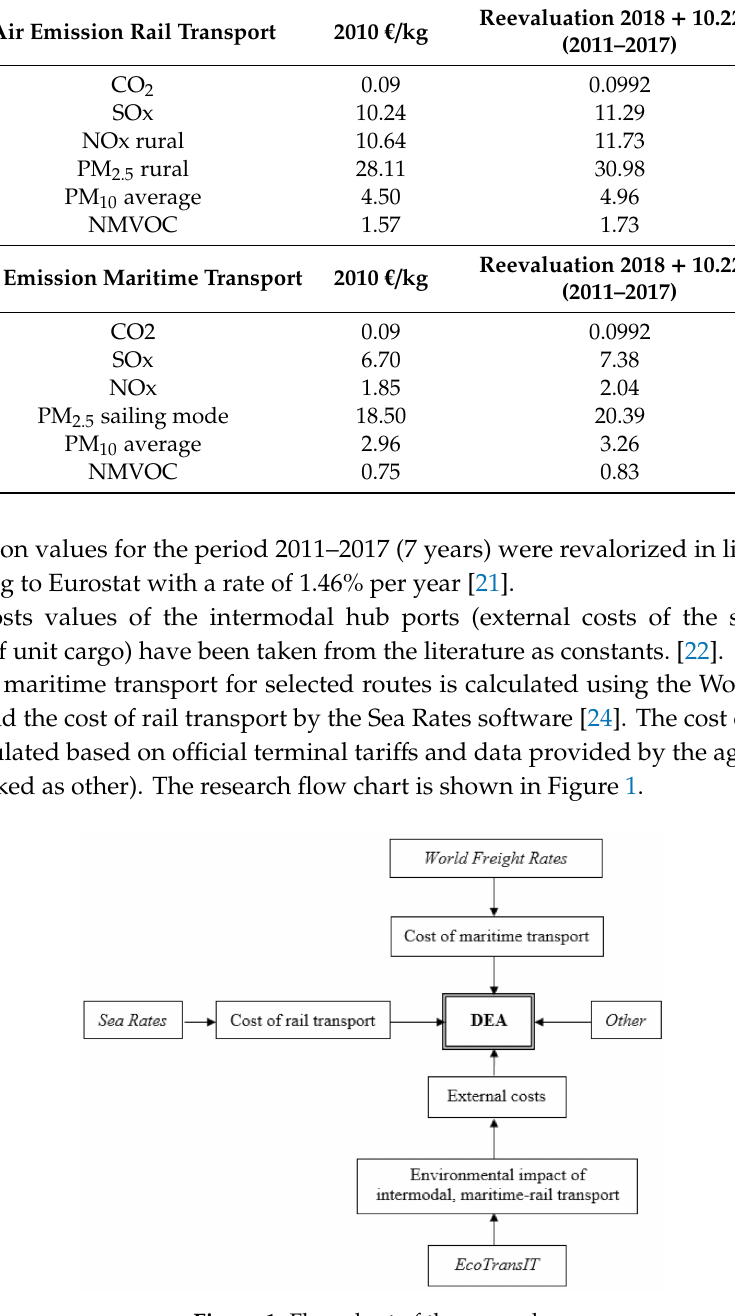
Figure 1. Flow chart of the